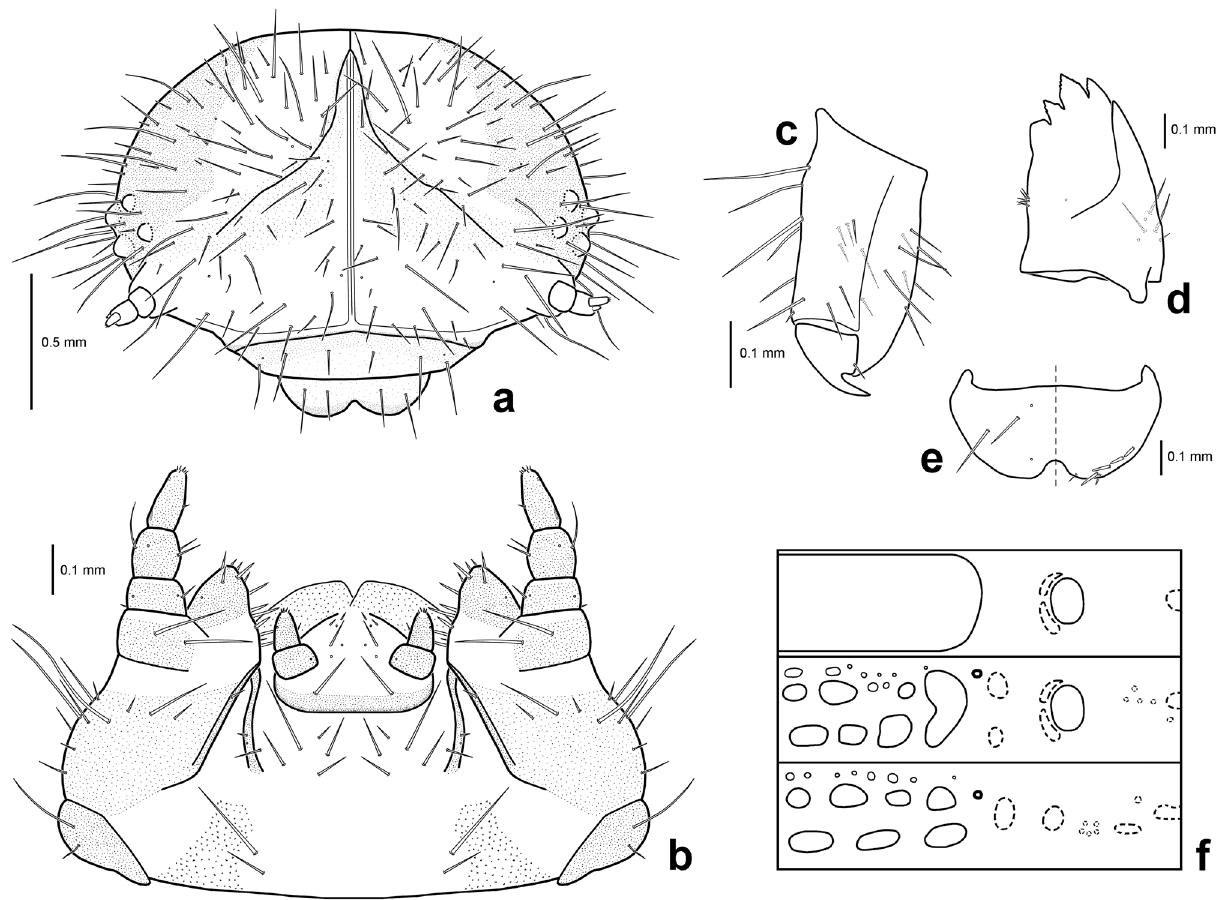
Figure 5. Larval morphology of Suinzona borowieci sp. nov.: (a) Head, (b) maxillae and labium, (c) tibiotarsus and pretarsus, (d) mandible, (e) labrum and epipharynx, (f) Schematic presentation of tubercular patterns (top: prothorax; middle: mesothorax; bottom: 2nd abdominal